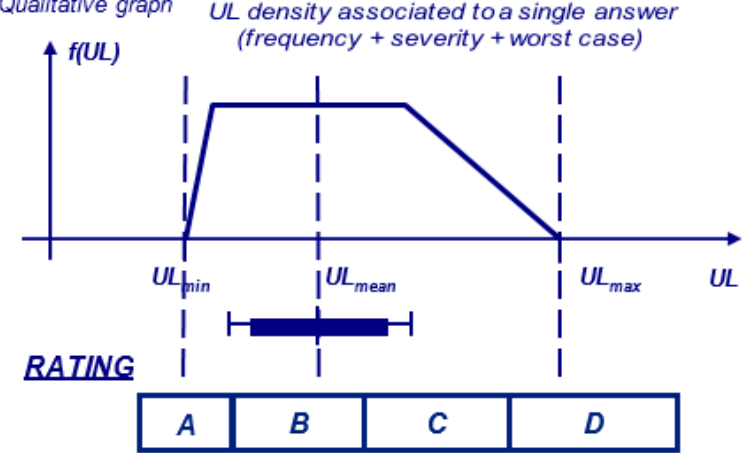
Figure 8. OpRSA Method. UL density function. Source: author own study.